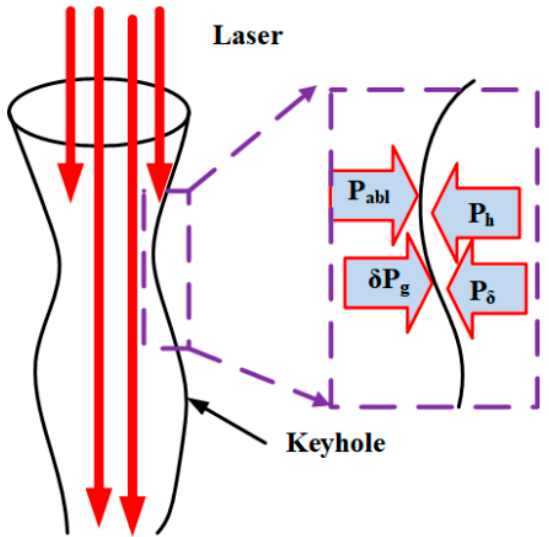
Figure 13. Force acting on the keyhole wall.